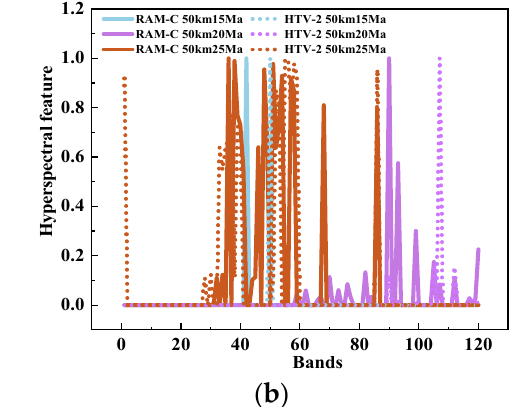
Figure 4. The HFs of RAM-C II and HTV-2 at typical flight states. ( a ) The flight states are 40 km 15 Mach, 40 km 20 Mach and 40 km 25 Mach. ( b ) The flight states are 50 km 15 Mach, 50 km 20 Mach and 50 km 25 Mach.